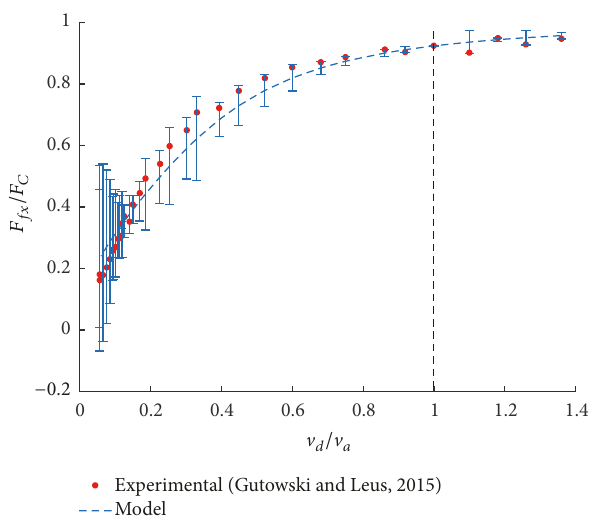
Figure 6: Comparison between the numerical simulation and experimental results.